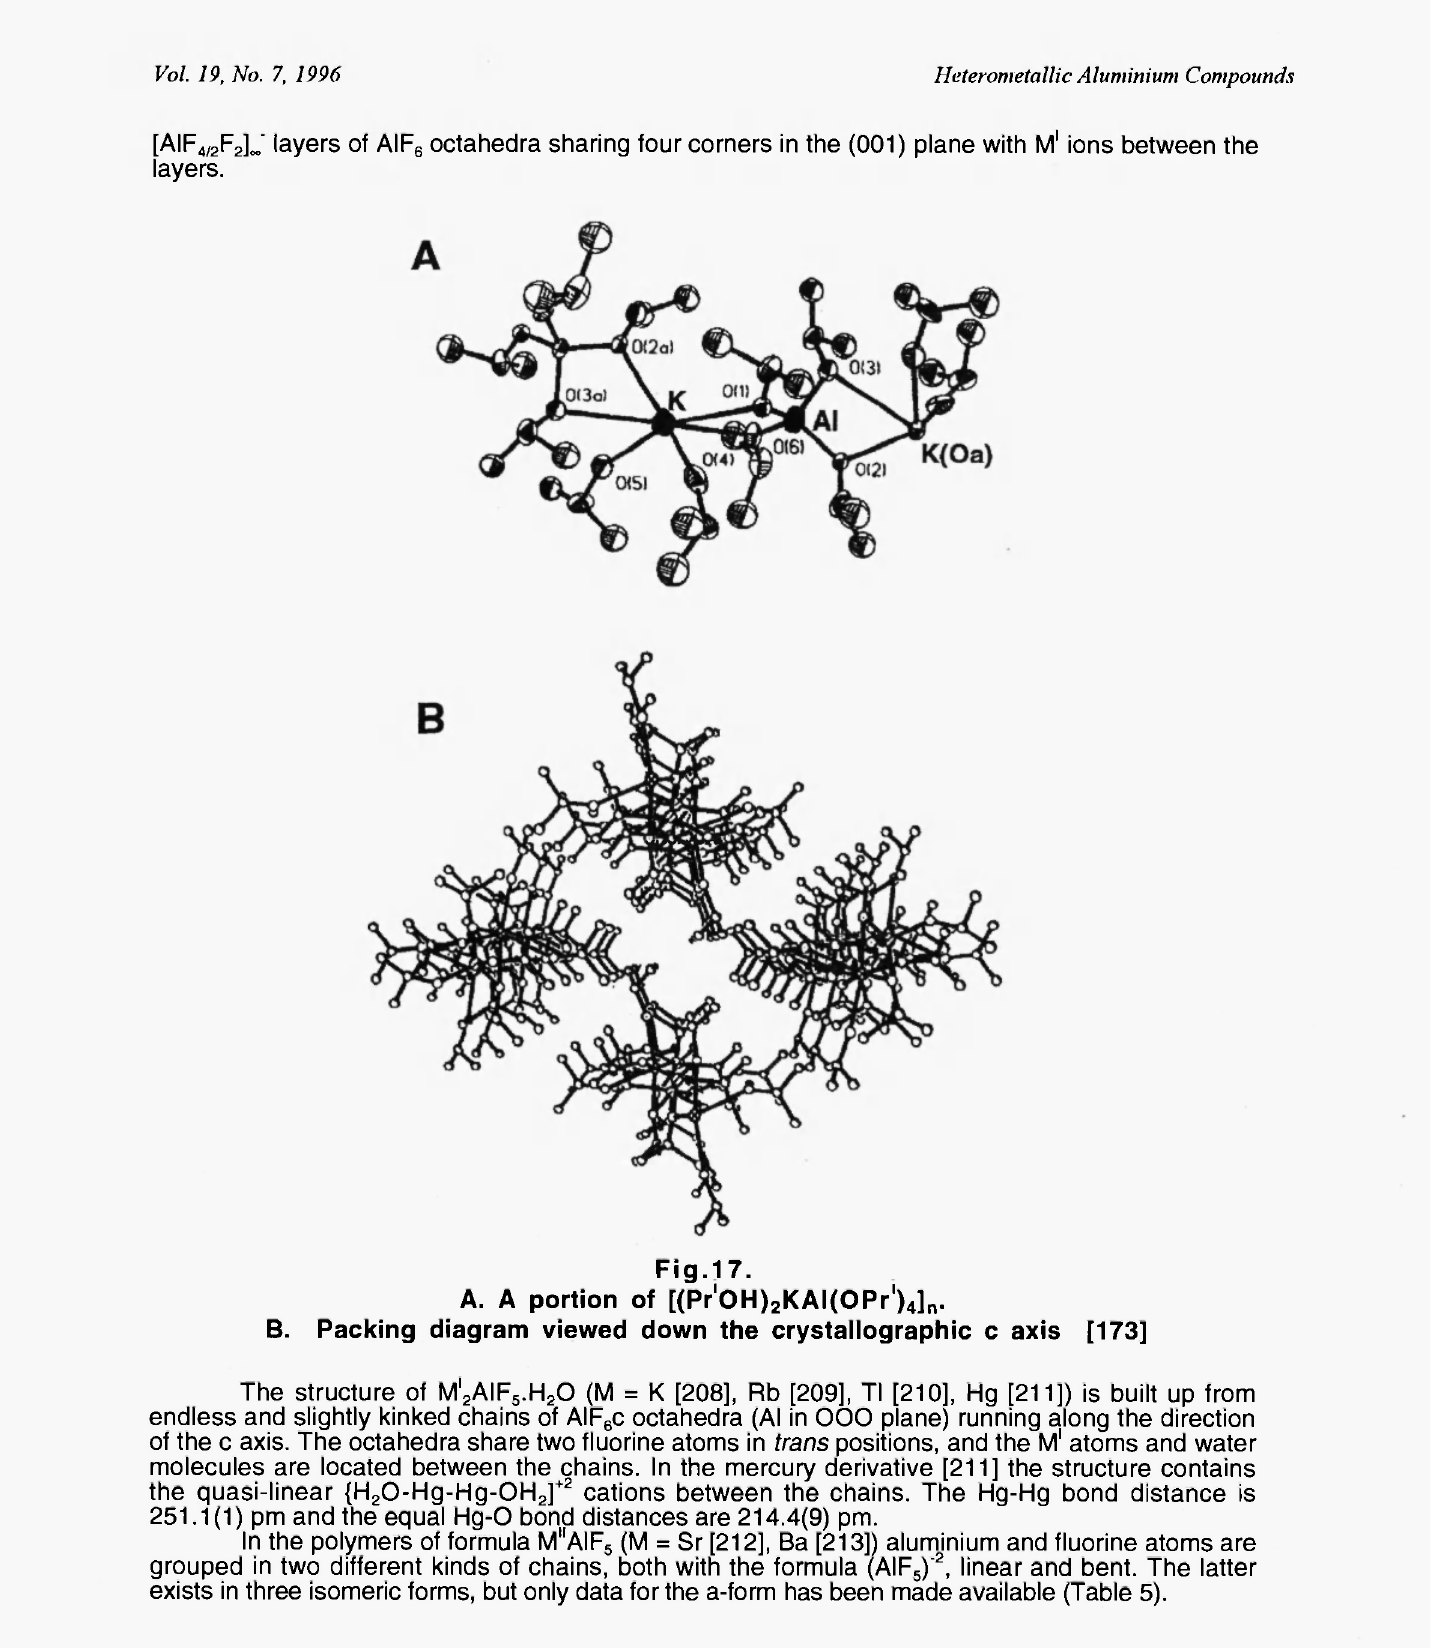
A. A portion of [(Pr'OH) 2 KAI(OPr') 4 ] n .